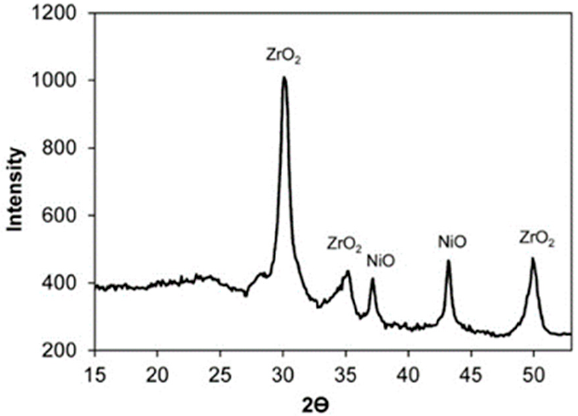
Figure 2. The XRD pattern of the 20% Ni/18%WO 3 -ZrO 2 catalyst. The size of NiO nanoparticles is 25 nm, the size of ZrO 2 nanoparticles is 13 nm.